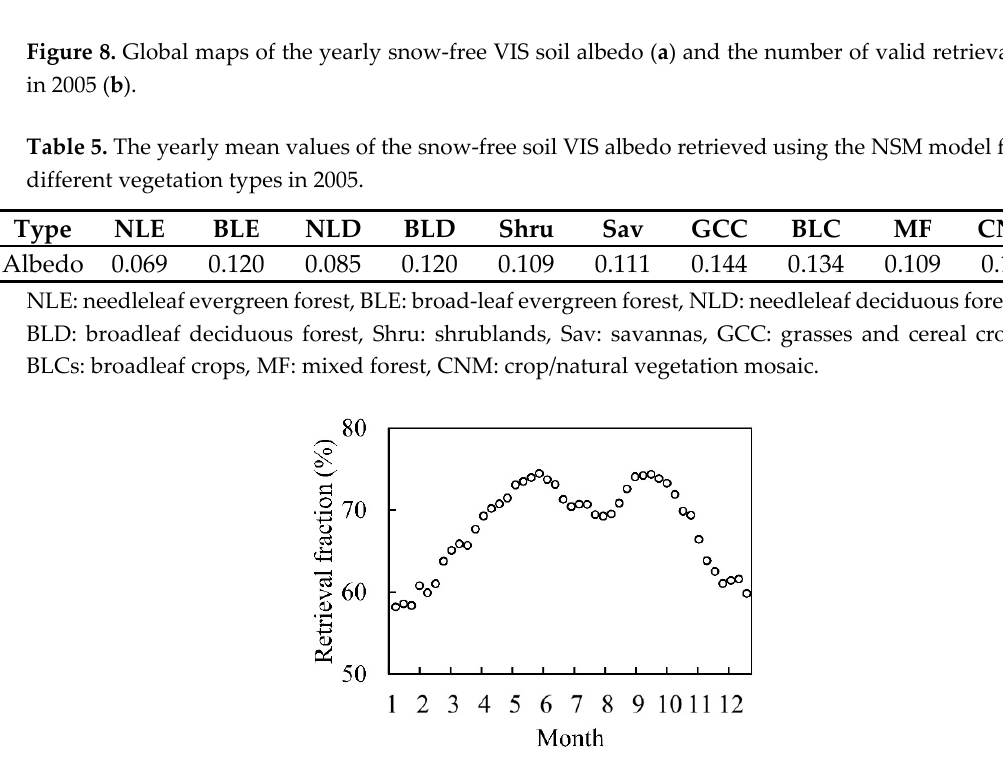
Figure 9. The global effective retrieval fraction for VIS soil albedo derived using the NSM model with MODIS products in 2005. If the retrieved soil VIS albedo was smaller than 0.02 or greater than 0.3 for a snow-free pixel with an FVC > 0.3, the pixel was marked as